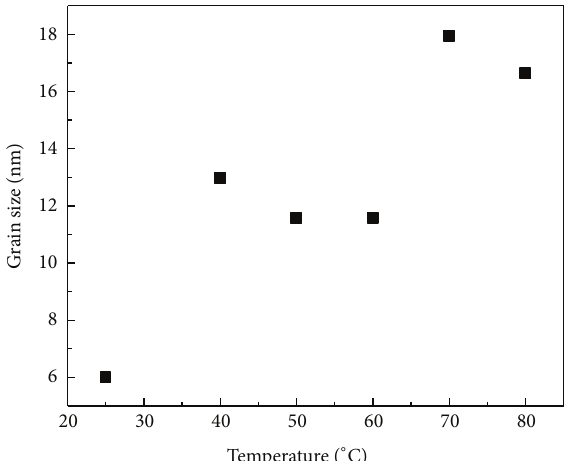
Figure 7: Grain size versus deposition temperature for galvanostatic deposition of CeO 2 on stainless steel with j = − 0.06mA/cm 2